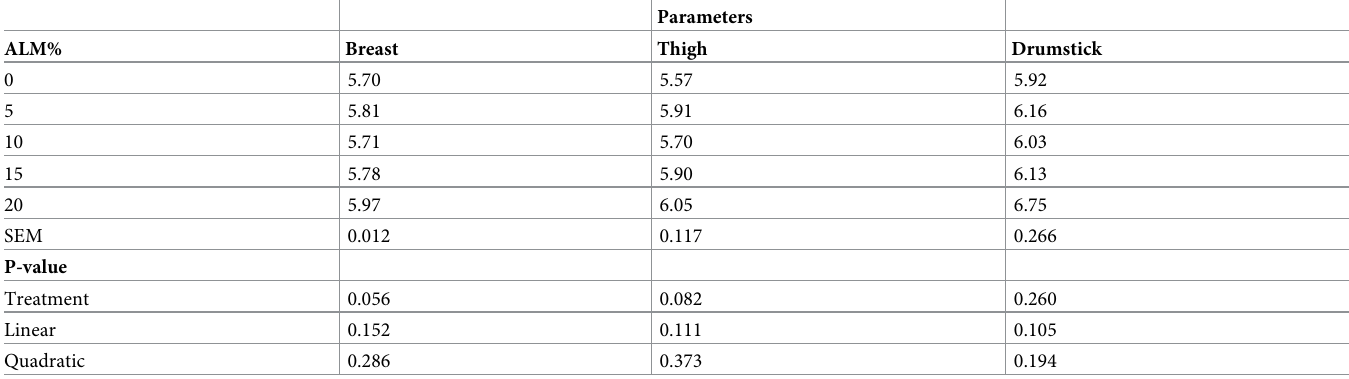
Table 6. Effect of amaranth leaf meal inclusion on meat parts pH of Ross 308 broiler chickens.